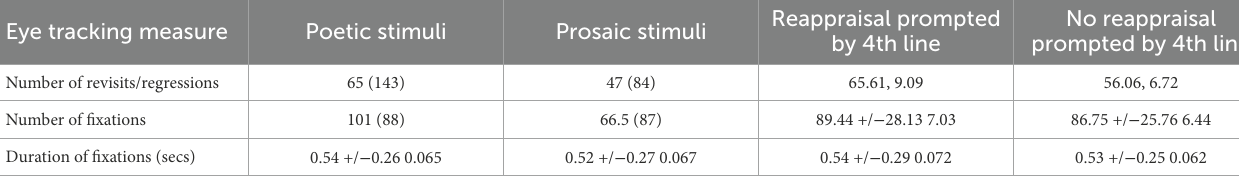
TABLE 2 Descriptive statistics for the eye tracking variables divided according to stimuli